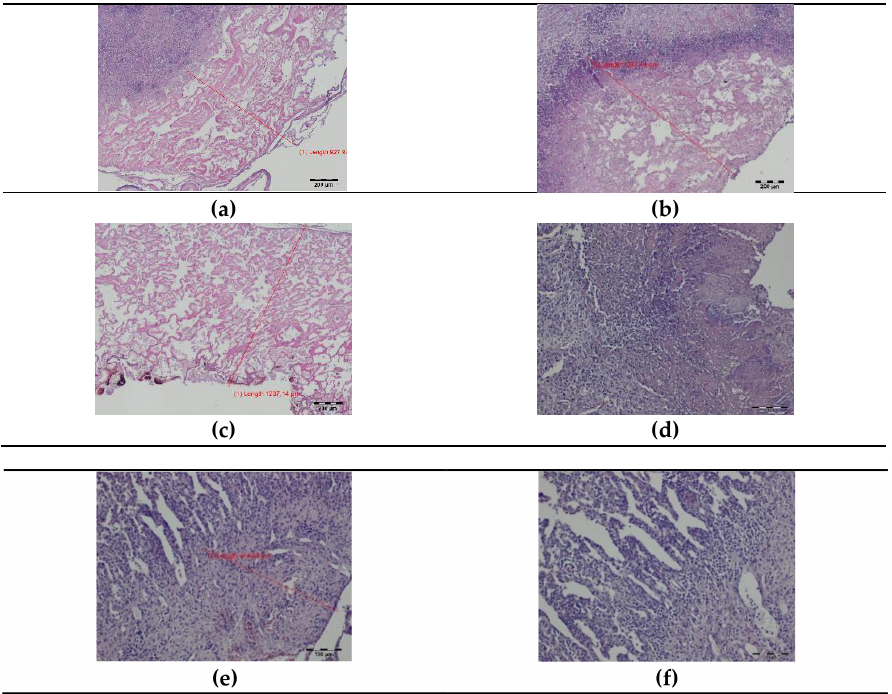
Figure 5. Histopathology of the lung tissue after a thulium-doped fiber laser (TDFL) cut on day 0: ( a – c ) total zone of laser thermal damage, magnification 100 × ; ( d , e ) superficial zone of laser thermal damage, magnification 100 × and 400 × ; HE staining.